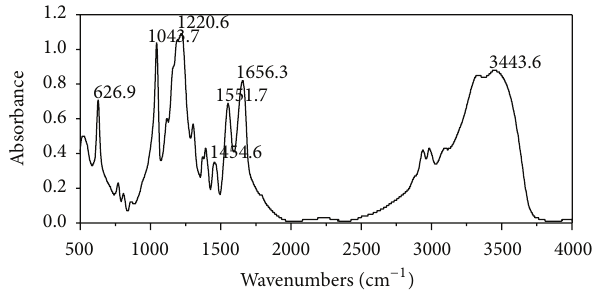
Figure 1: FTIR spectrum of PAMPS